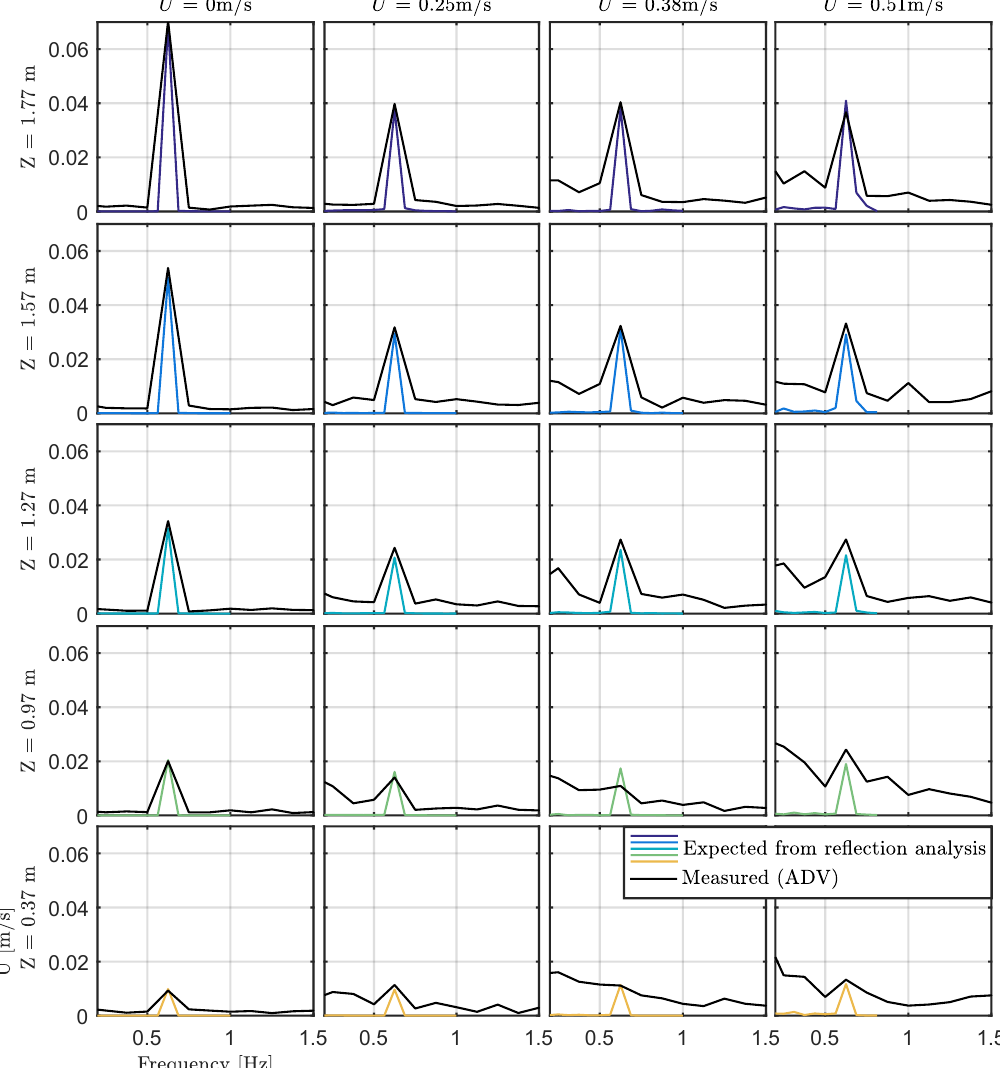
Figure 13. Measured horizontal velocity spectra compared with those expected from theory. Shown for regular wave cases (Sea States 1–4, Table 3) for each of the five ADV